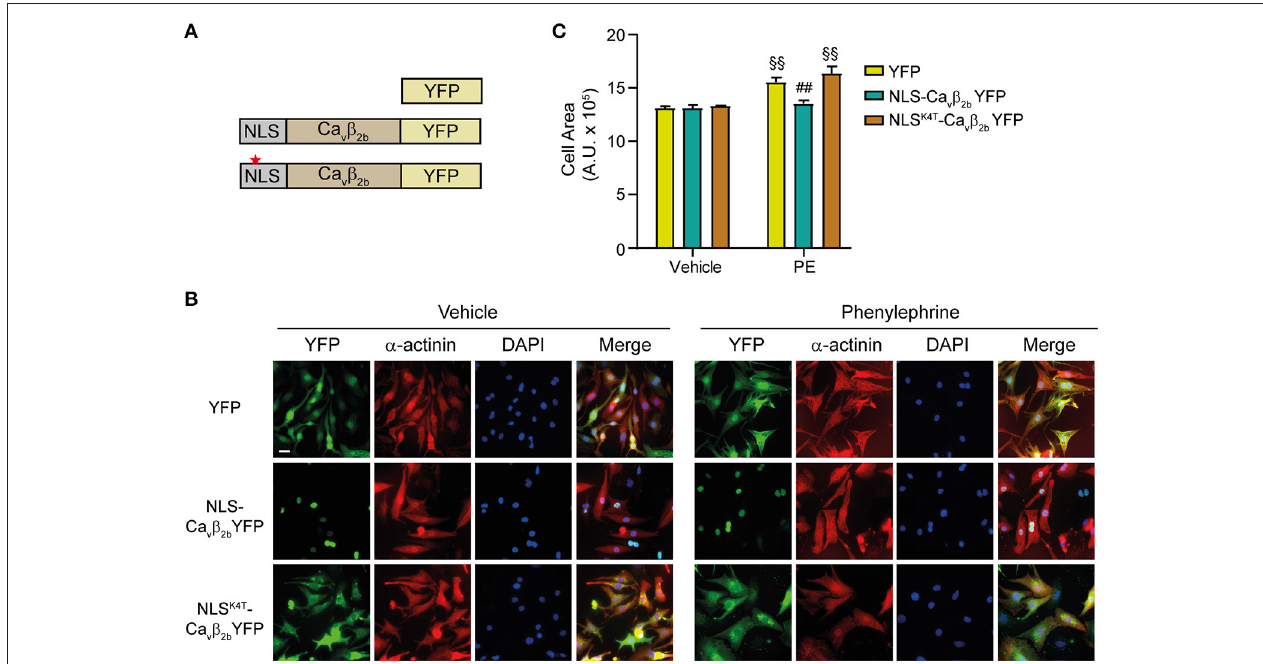
FIGURE 5 | Nuclear overexpression of Ca v β 2 abolishes in vitro PE-induced cardiomyocyte hypertrophy. (A) Schematic representations of the three evaluated constructs. To achieve a complete Ca v β 2 nuclear-targeting, the nuclear localization signal (NLS) of the SV40 large T-antigen (PPKKKRKV) was inserted at the N-terminus of the Ca v β 2b -YFP construct (NLS-Ca v β 2b -YFP). YFP and a construct with a mutated NLS (NLS K4T -Ca v β 2b -YFP, red star) were used as negative controls. (B) Fluorescent images of NRCs expressing the controls (YFP or NLS K4T -Ca v β 2b -YFP) or nuclear overexpressed Ca v β 2b (NLS-Ca v β 2b -YFP) and treated with vehicle or 50 µ M phenylephrine (PE). Cells were stained for α -actinin (red) and nucleus (DAPI, blue), while the YFP fluorescence was directly monitored. Scale bar represents 25 µ m. (C) Bar plot of the cell area analyses of NRCs expressing YFP, NLS-Ca v β 2b -YFP or NLS K4T -Ca v β 2b -YFP after the treatment with vehicle or PE. Mean ± SEM; 150–200 cells per group from 20 randomly chosen fields from 3 replicated experiments were measured; §§ p < 0.01 vs. vehicle-treated cells in the same group; ## p < 0.05 vs. YFP expressing cells treated similarly (two-way ANOVA with Holm–Sidak’s